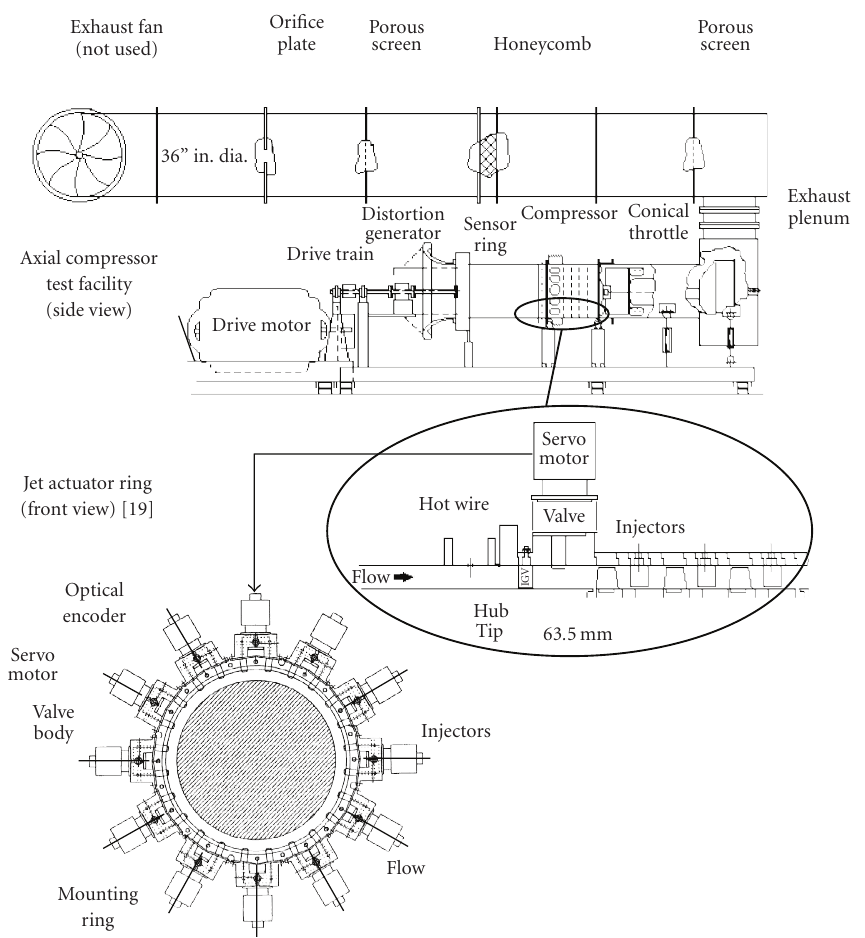
Figure 1: MIT low-speed three-stage axial compressor test facility with jet actuation.